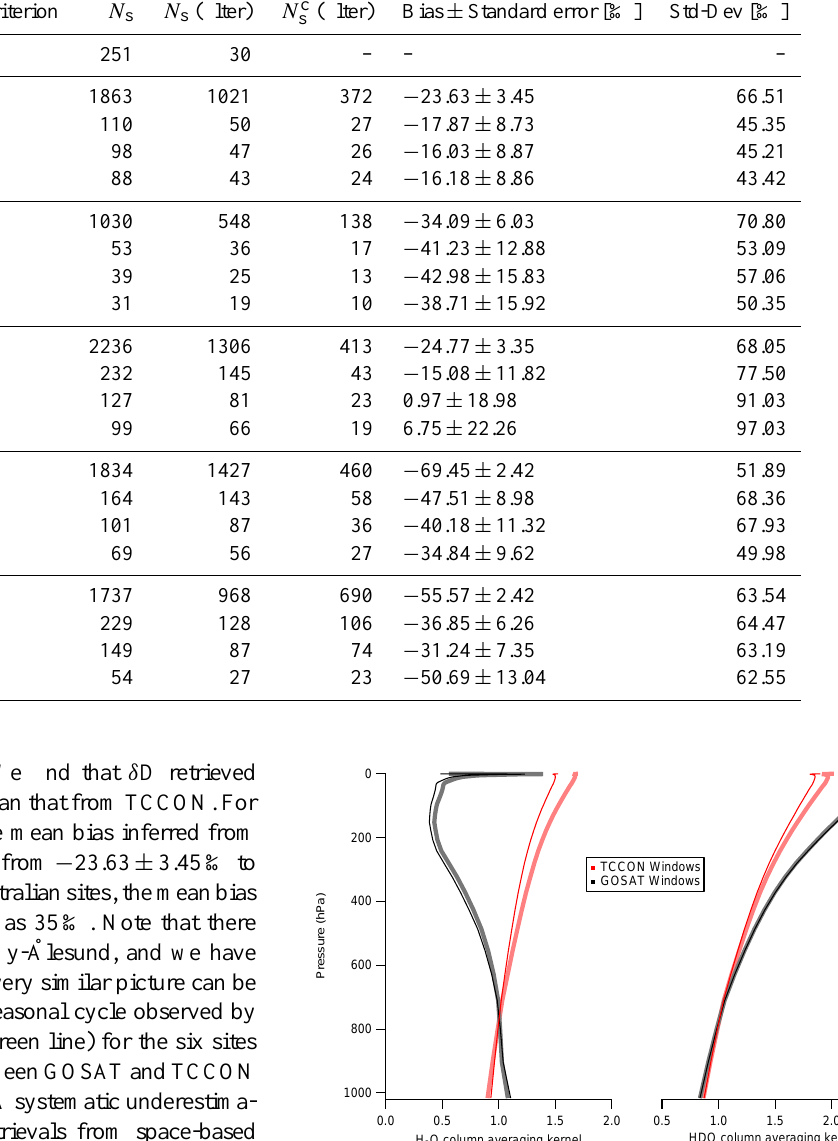
Table 2. Overview of the GOSAT–TCCON comparisons for six TCCON sites (Ny- ˚Alesund, Bialystok, Bremen, Orleans, Darwin and Wol- longong). The following data are given for each of the six TCCON sites, from left to right: the number of cloud-free soundings after basic filtering N s and after full quality filtering N s (filter); the number of filtered, coincident soundings N c s (filter); the mean bias in δ D and standard error; and standard deviation inferred from the coincident soundings N c s (filter). All values are given for 4 different spatial co-location criteria. Note that for Ny- ˚Alesund no coincident soundings are found.